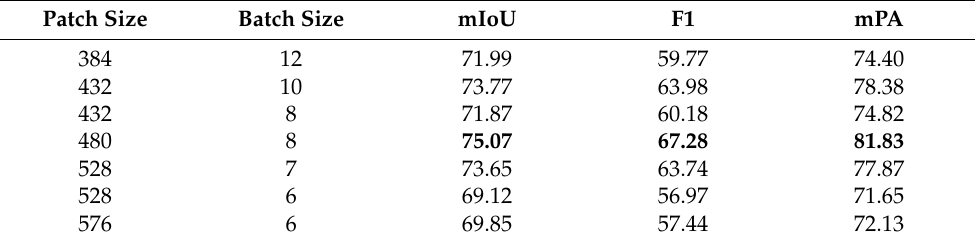
Table 6. Comparison of patch size and batch size on validation set. Best results are in bold. Patch Size Batch